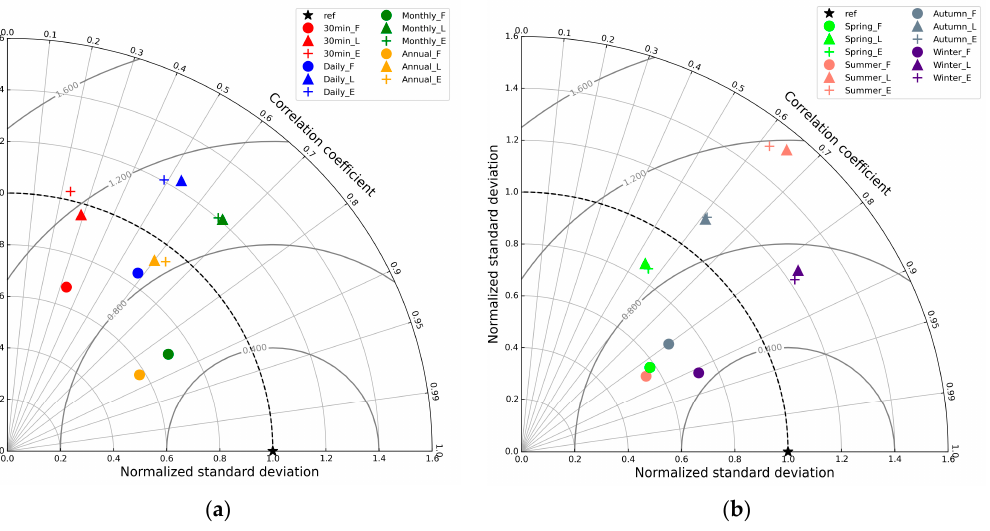
Figure 5. ( a ) Taylor diagram at sub-daily, daily, monthly, and annual scales of the products IMERG_E, IMERG_L and IMERG_F. ( b ) Same as the ( a ) figure but shows seasonal scales. In the seasonal analysis (Figure 5b), IMERG_E and IMERG_L overestimate the precipitation values substantially. These errors are more noticeable during the summer period with a systematic error of over 97 mm and MAE and RMSE values around 105 mm and 143 mm, respectively. Interestingly, in this period, IMERG_F introduces significant